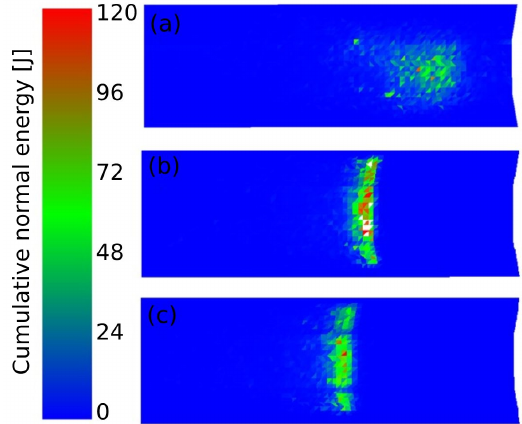
Figure 11. Distribution of the cumulative normal energy transferred by the material stream to the receiving belt after 60 s of simulation: ( a ) current transfer station, ( b ) 60° chute, and ( c ) 45°